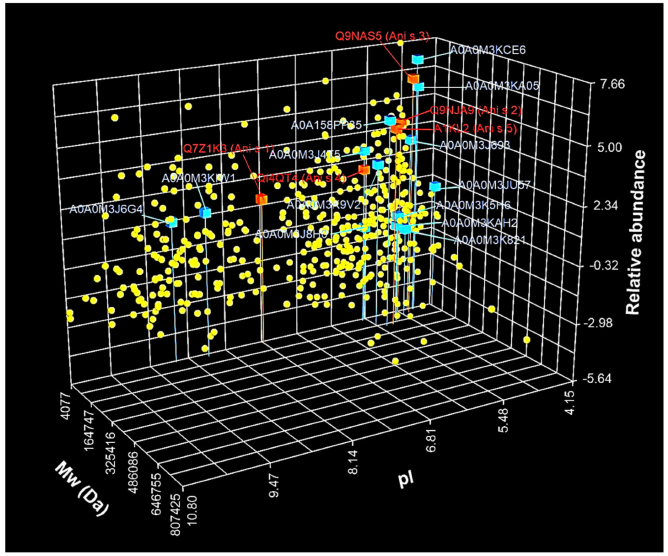
Figure 2. The three-dimensional scatter plot analysis of A. simplex proteins ( n = 470) identified using LC-MS / MS. The proteins were distributed based on molecular weight (Mw), isoelectric point (pI), and the relative abundance of proteins. The Mw and pI values were calculated using the ExPASy Compute pI / Mw tool, while the relative abundance was estimated based on the average exponentially modified protein abundance index (emPAI) values (mean of three biological replicates) calculated by Mascot. The relative abundance is shown in log2 scale. Red cubes are allergens ( n = 5), and cyan cubes are potential allergens ( n = 13). Cubes (allergens and potential allergens) are signed with UniProt ID and have a vertical line for better pI and Mw visualization. Yellow spheres are the other identified proteins. A scatter plot was constructed using Teraplot software (ver. 1.4.06; Kylebank Software Ltd., Ayr,